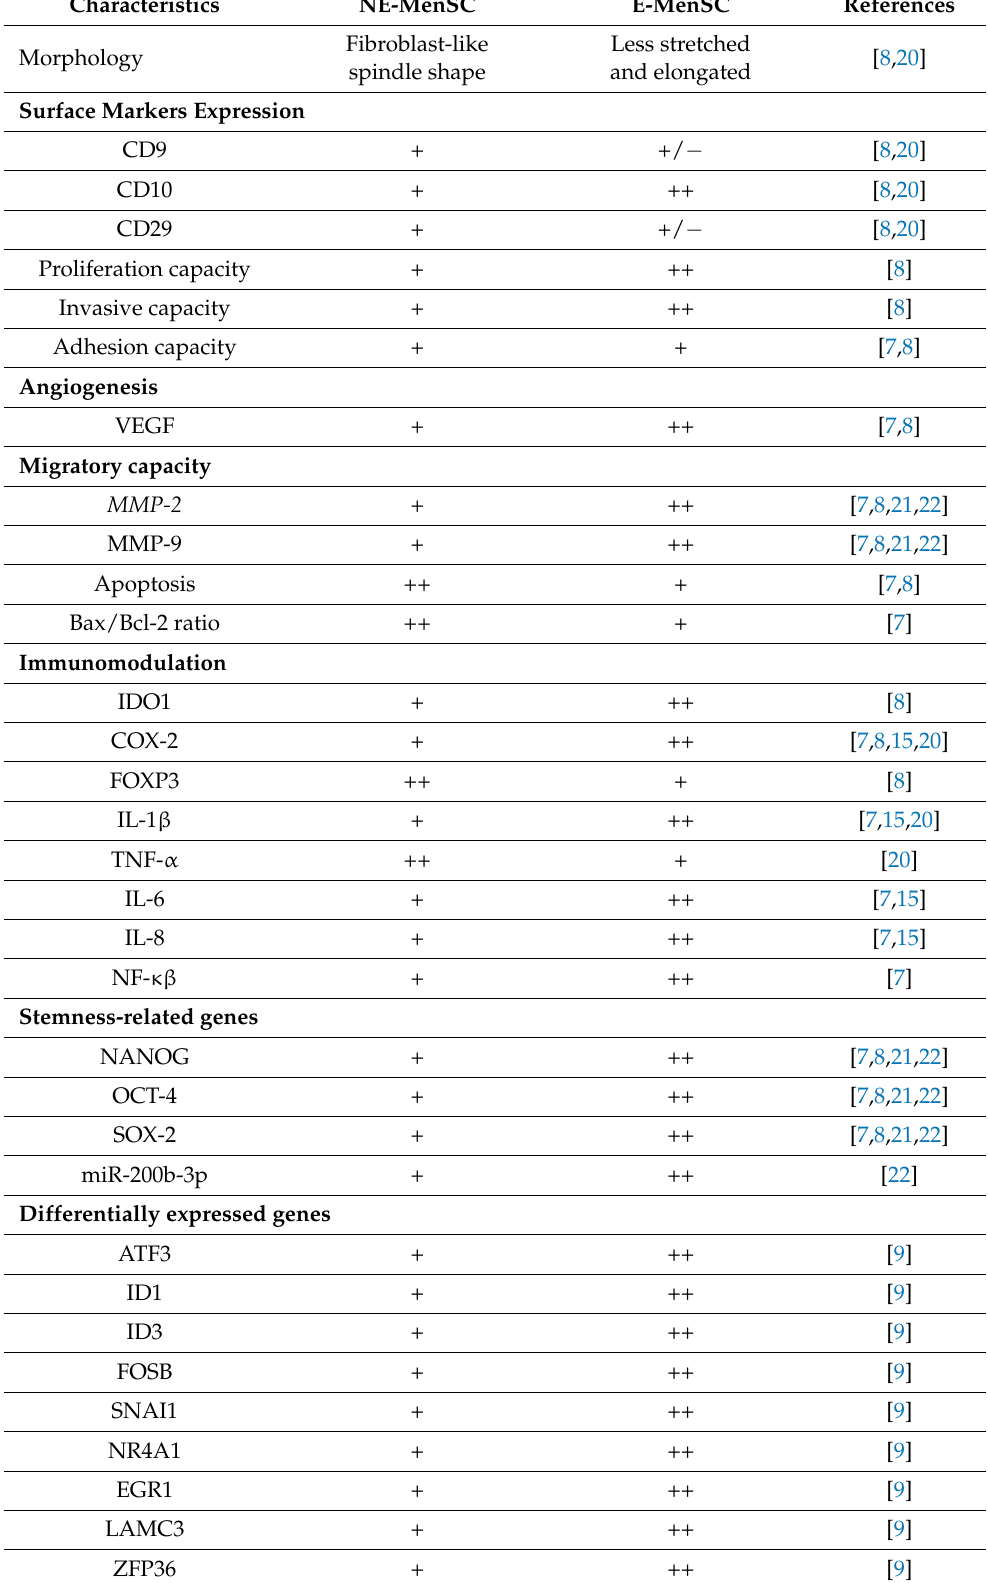
Table 1. Differences in MenSC observed between patients without endometriosis vs. patients with